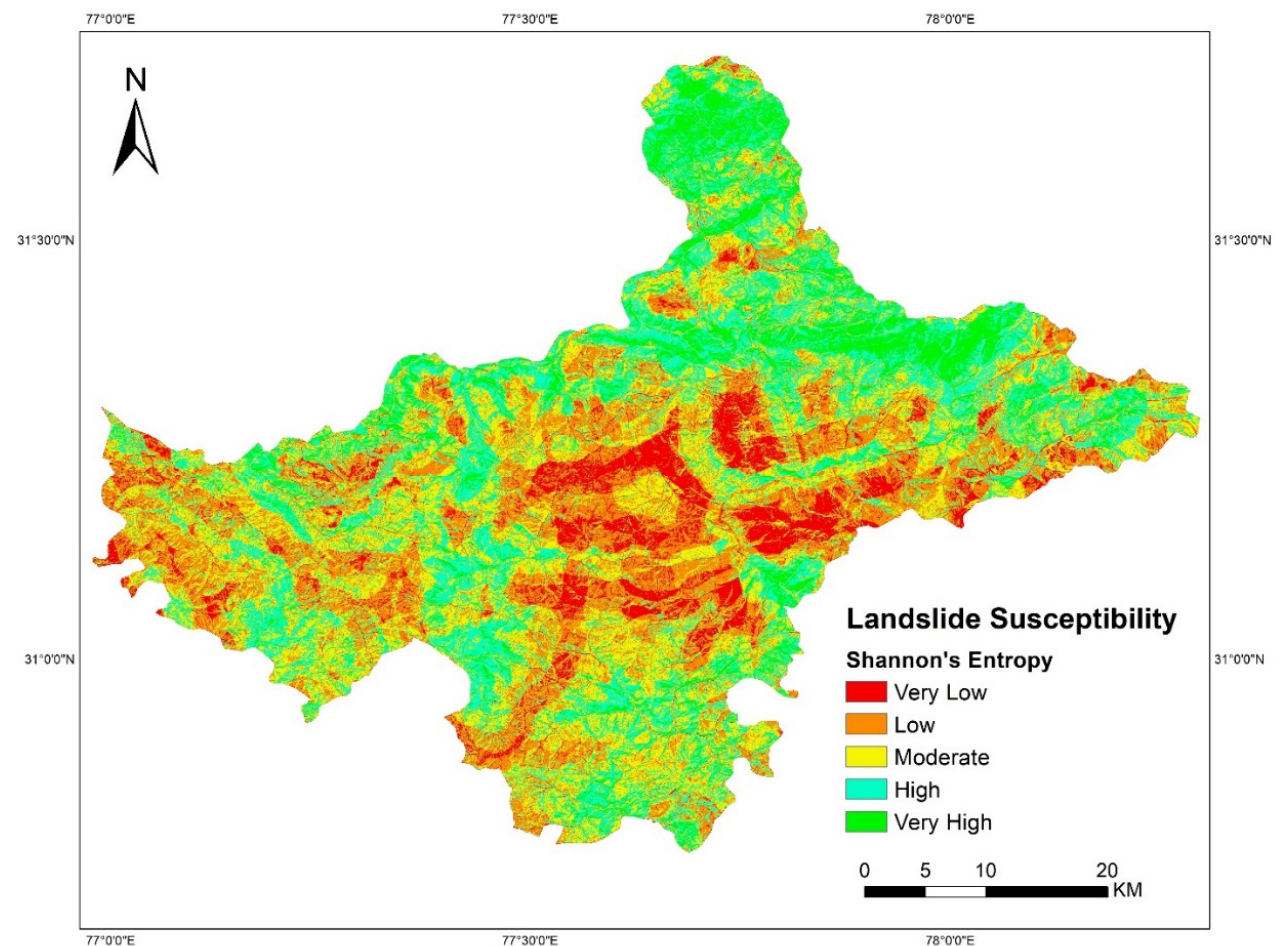
Figure 6. Landslide susceptibility map using Shannon’s entropy.